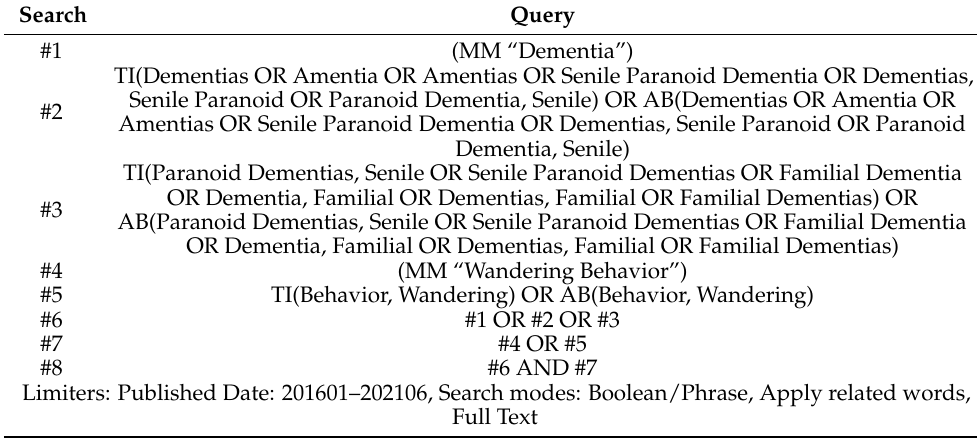
Table A4. CINAHL search strategy.